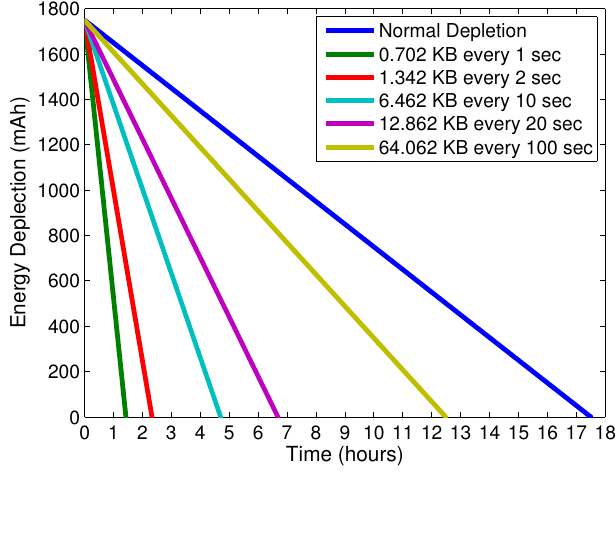
Figure 6. Battery consumption for different transmission schemes using